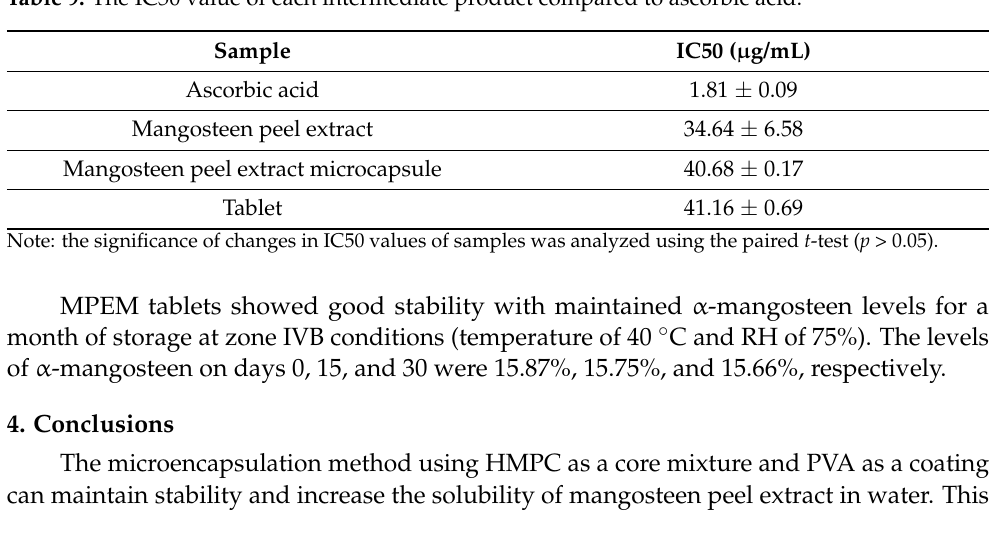
Table 9. The IC50 value of each intermediate product compared to ascorbic